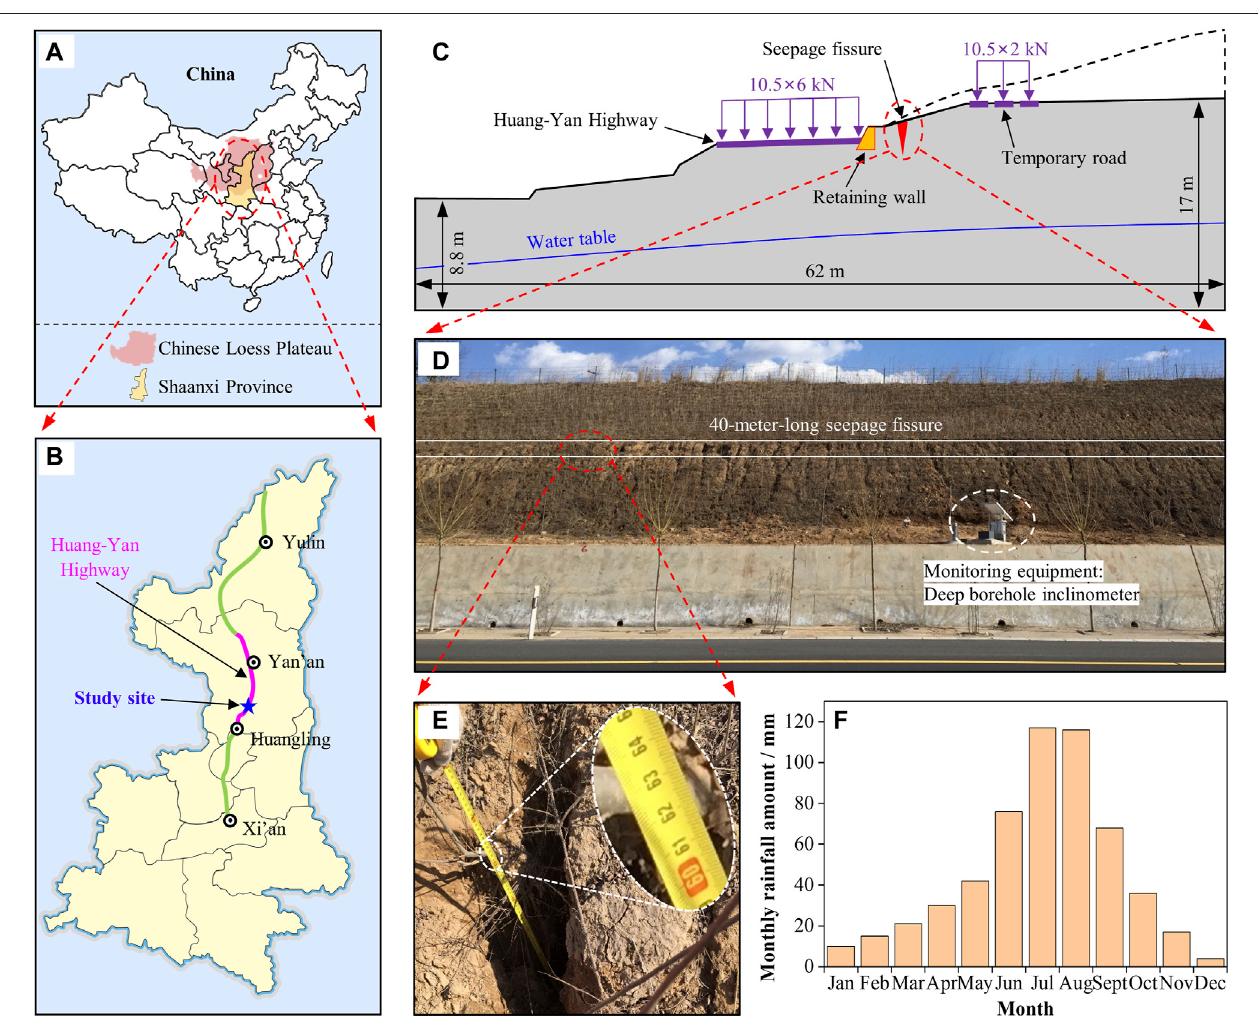
FIGURE1| Overview oftheYangpoyaoslope: (A,B) location ofthe site, (C) cross-sectionofthe slope, (D,E) a fi ssure on theslopeand (F) statisticaldistributionof monthly average rainfall.